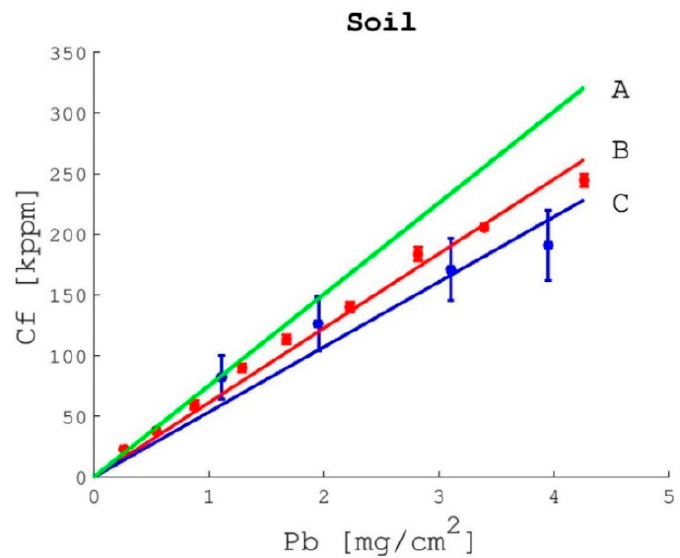
Figure 4. Linear fit F = a× x of the data from the intensity measurements with the soil calibration (A: tangent at 0 of the exponential relationship; B: linear approximation in the case of a plasterboard substrate; C: linear approximation in the case of a concrete substrate).